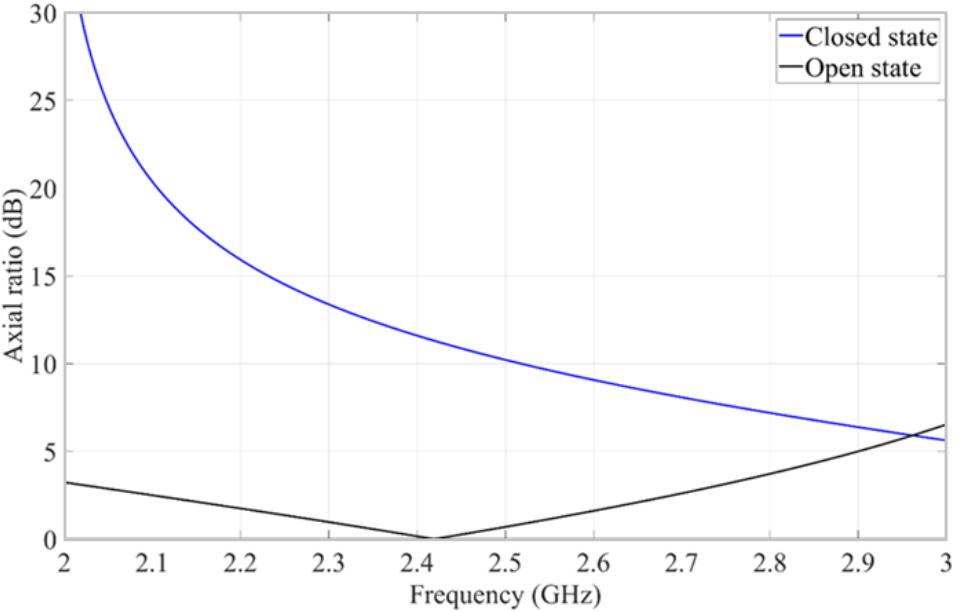
Figure 4. Simulated axial ratio of the reflected fields from the designed reflector-backed metasurface in a closed and open state. Table 1. Antenna parameter